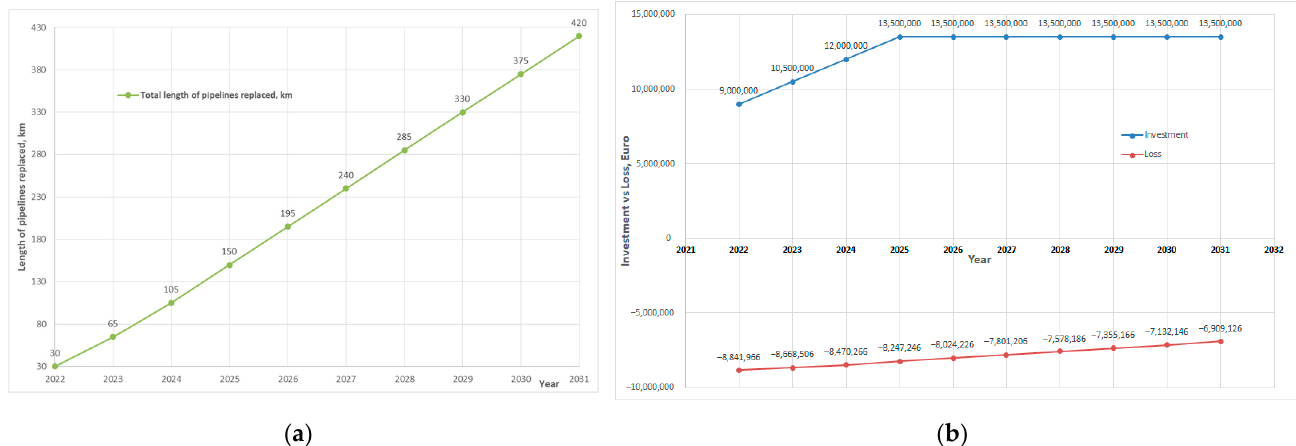
Figure 11. Lengths replaced, amounts invested and reduction in losses—scenario 1: ( a ) planning lengths to be replaced, km; ( b ) investment costs and loss mitigation, EUR (source: authors based on the analysed data).